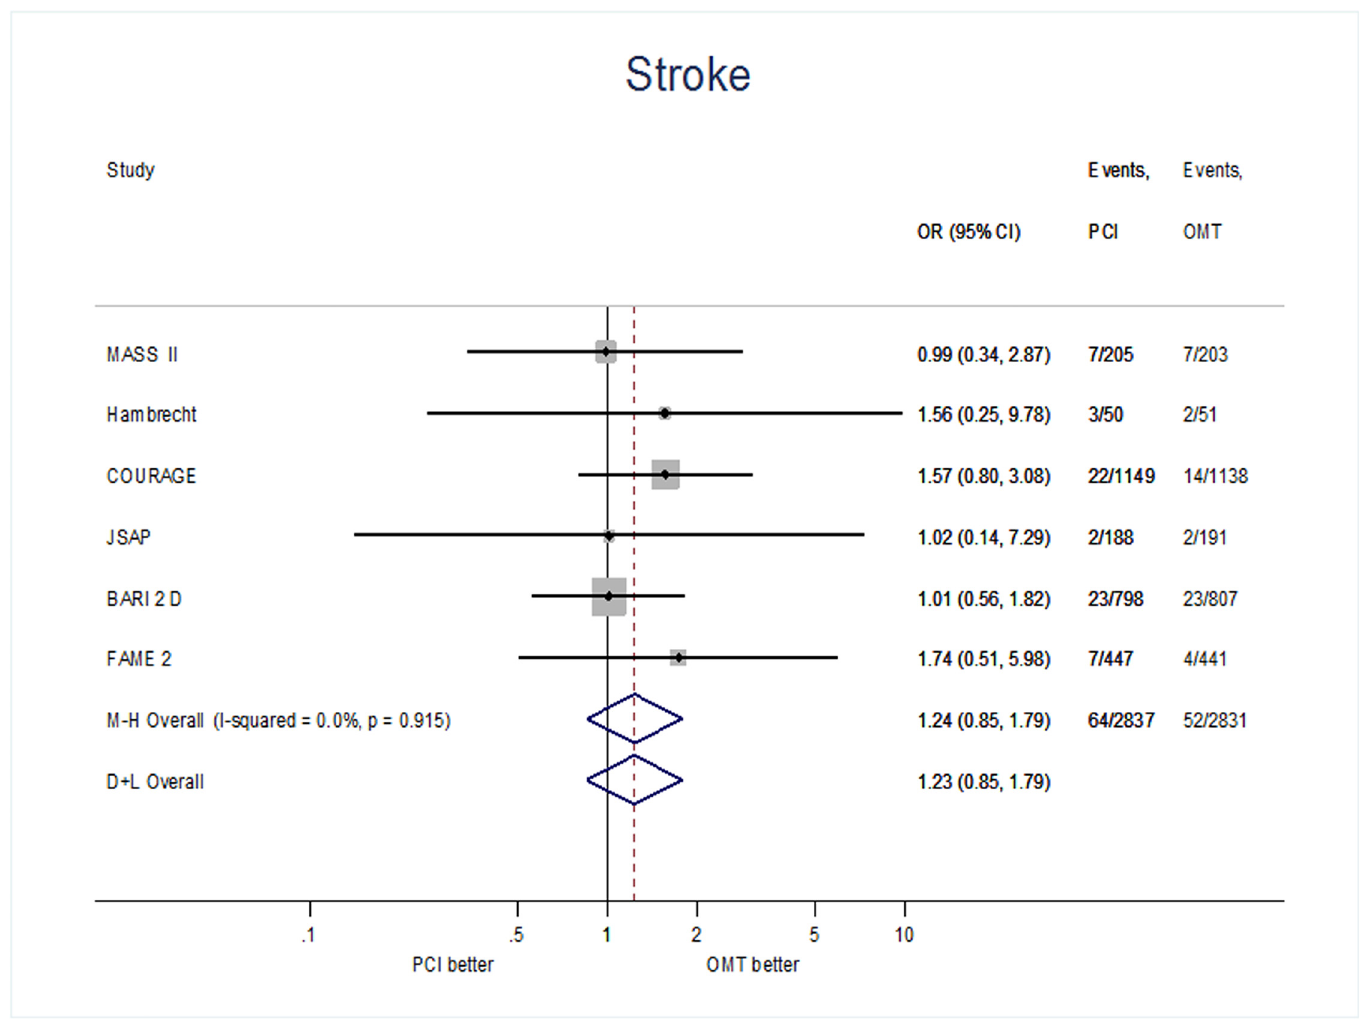
Fig 2. Risk of stroke in patients with PCI based strategy vs. patients with OMT based strategy. Abbreviations: CI = confidence intervals.